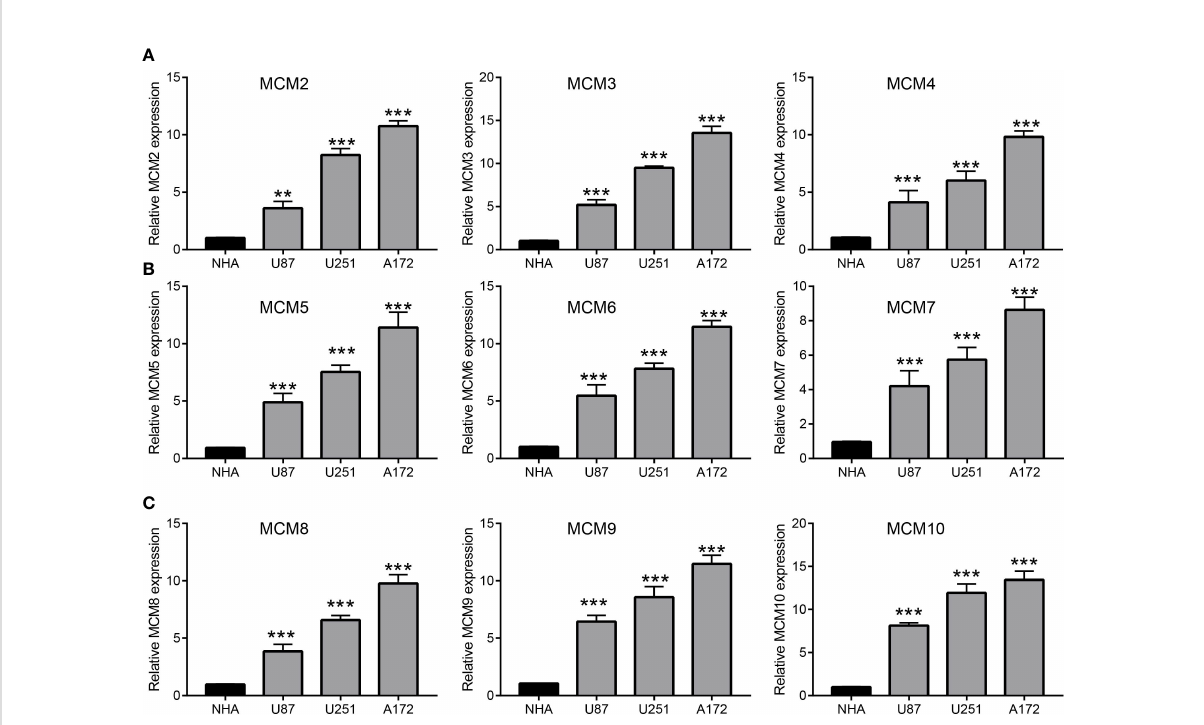
FIGURE 2 Analysis of the expression of MCMs in glioma cell lines. (A – C) The expression level of MCMs in glioma cell lines examine by qRT-PCR assay. **p < 0.01, ***p <